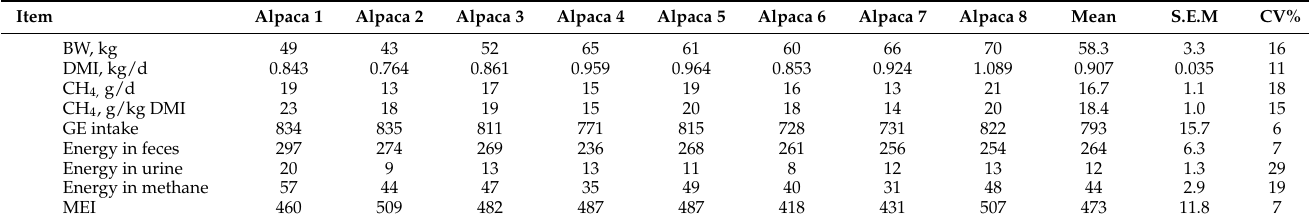
Table 3. Energy partitioning (kJ/kg BW 0.75 ) and carbon–nitrogen (g/kg BW 0.75 ) balances of adult alpacas (n = 8) fed at a maintenance level of